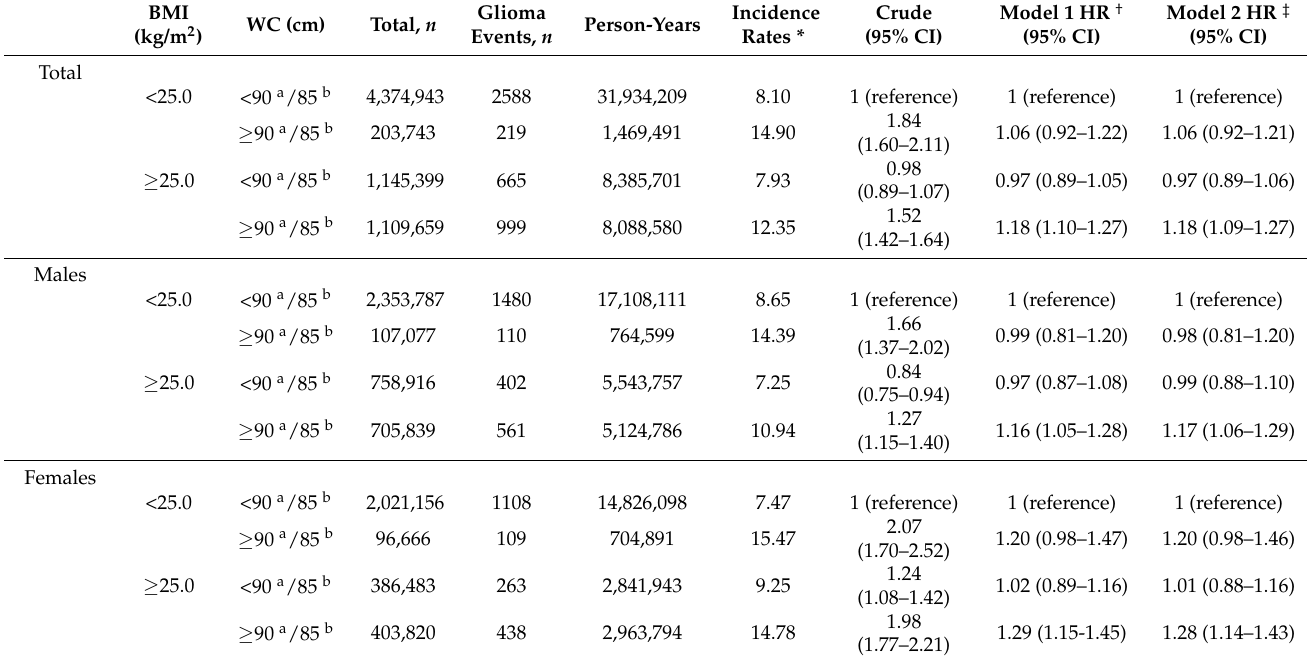
Table 3. Impact of abdominal obesity on the association between BMI and risk of glioma development.